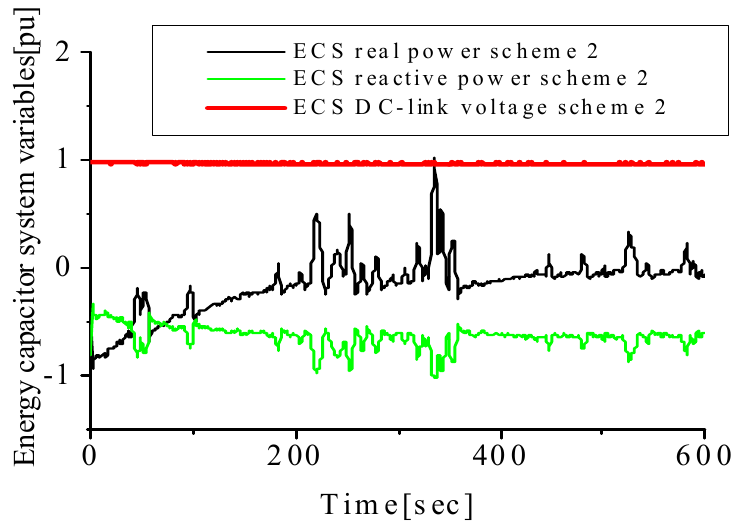
Figure 14. Energy capacitor variables in wind farm B.